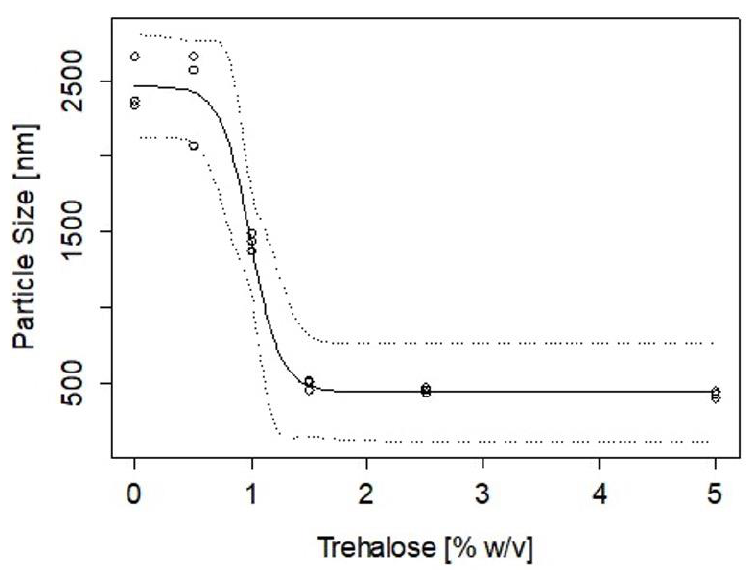
Figure 5. Particle size differences of freeze-dried nanoparticles after resuspension with a logistic model fit where the top and bottom dash lines represent the 95% confidence coverage.